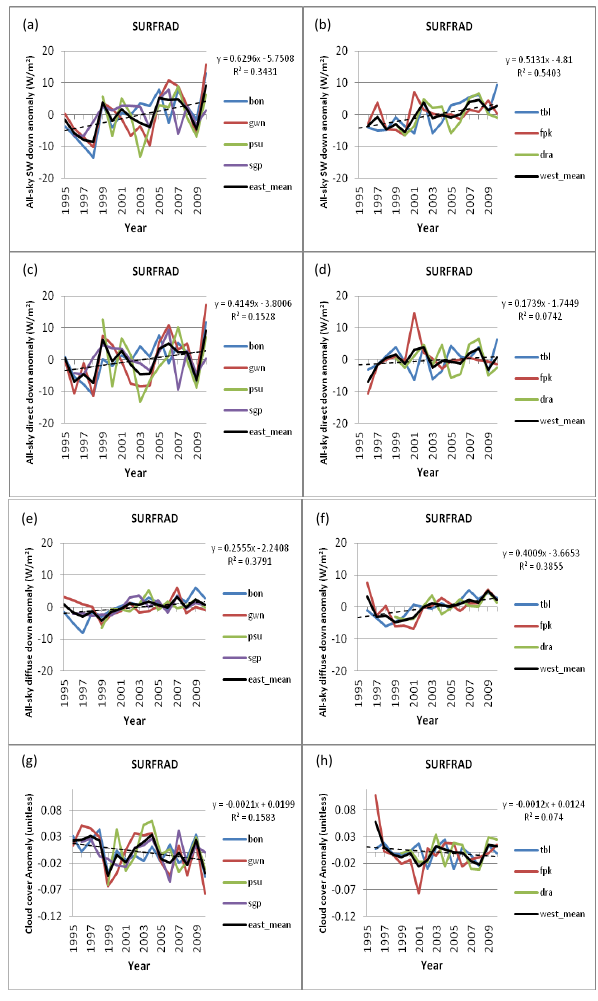
Figure 8: Annual anomalies of all-sky downwelling SW (first row), direct SW (second row), 3 Fig. 8. Annual anomalies of all-sky downwelling SW (first row), di- diffuse SW (third row) and cloud cover fraction(fourth row) from SURFRAD for each site 4 rect SW (second row), diffuse SW (third row) and cloud cover frac- (colored line) and the network mean (solid black line) together with the LSF (dash black line) 5 tion(fourth row) from SURFRAD for each site (colored line) and to the network mean. The best-fit equation and coefficient of determination (R 2 ) are given at 6 the network mean (solid black line) together with the LSF (dash right in each panel. The left column represent eastern US while the right column represent 7 black line) to the network mean. The best-fit equation and coeffi- cient of determination ( R 2 ) are given at right in each panel. The left column represents eastern US while the right column represents western